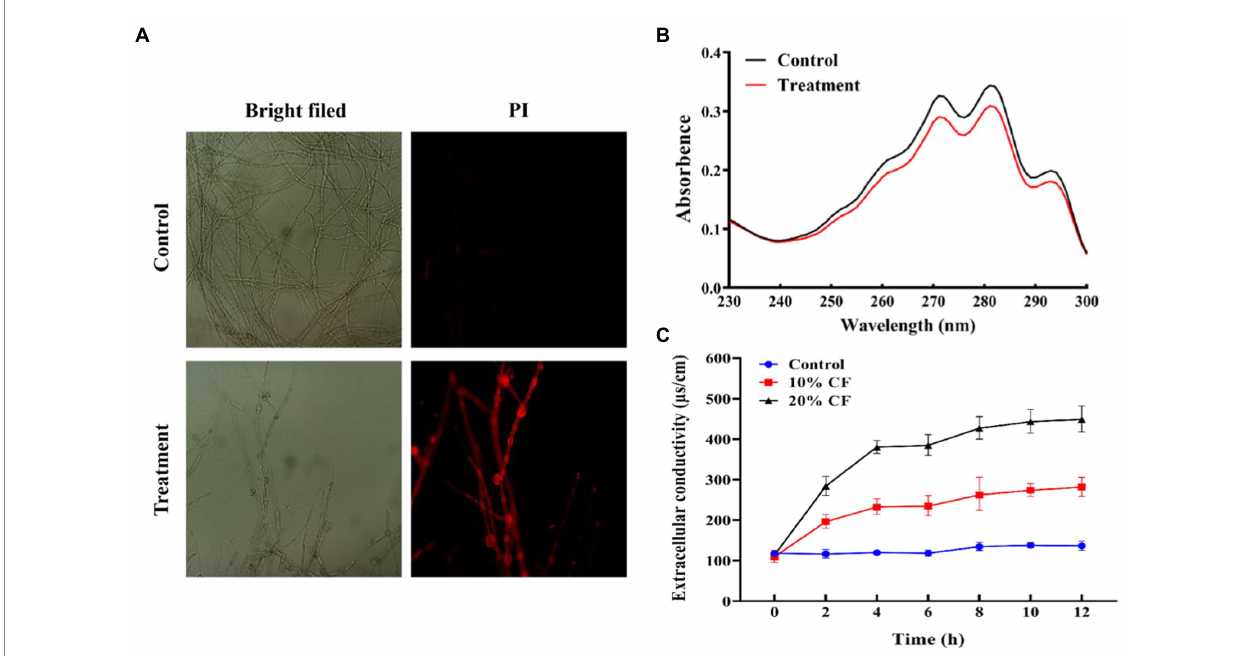
FIGURE 4 Effect of cell-free culture filtrate on membrane integrity of Bipolaris sorokiniana mycelium. (A) Fluorescence of mycelia stained with PI measured by revolve fluorescence microscopy (×20). (B) Ultraviolet scanning spectra of ergosterol content in the mycelium plasma membrane treated with cell-free culture filtrate. (C) Effects of cell-free culture filtrate on the electric conductivity of mycelium. Values are presented as mean ± SE ( n = 3).